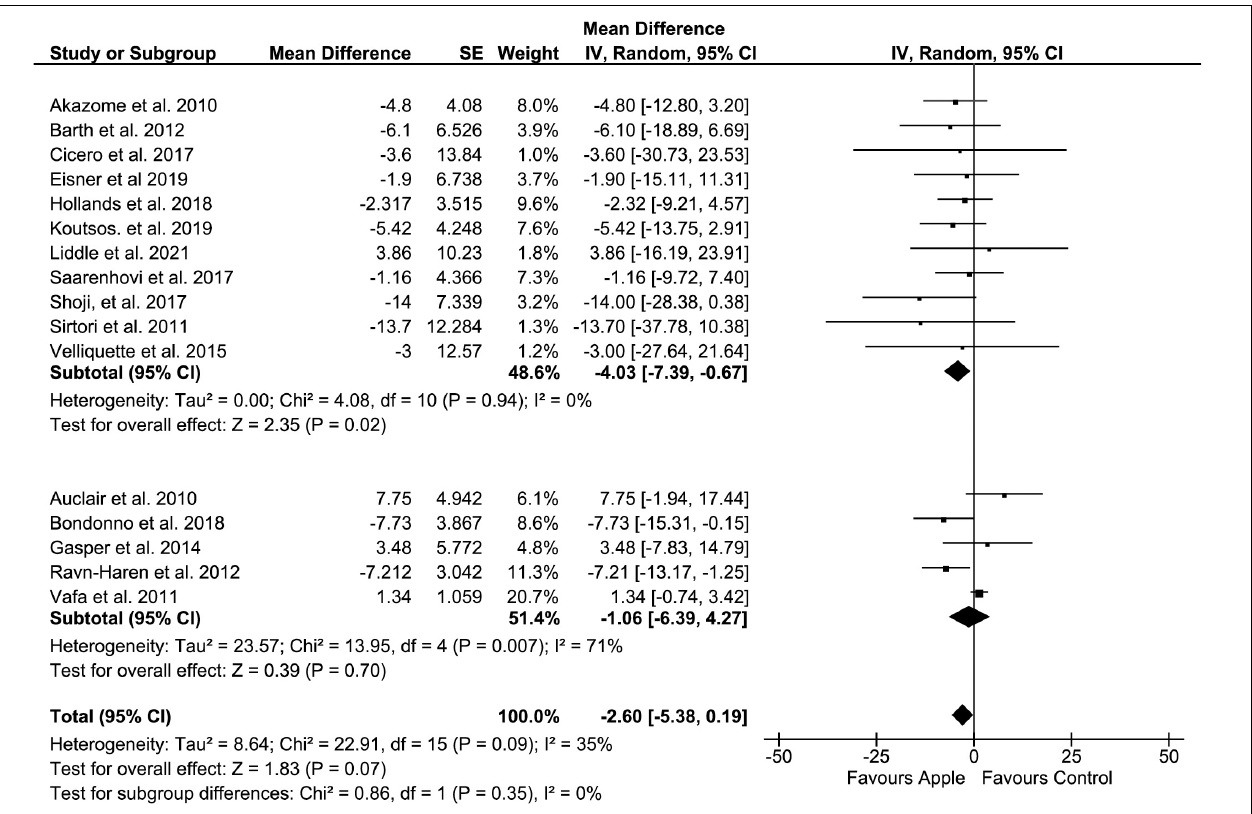
FIGURE 3 | Meta-analysis results of low-density lipoprotein. Forest plot is stratified by placebo diet or other alternative